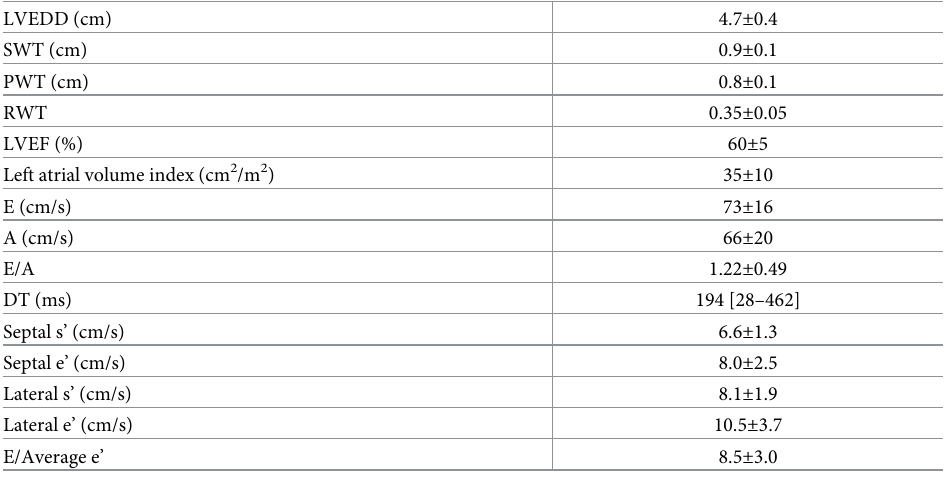
Table 2. Echocardiographic variables in subjects with systemic